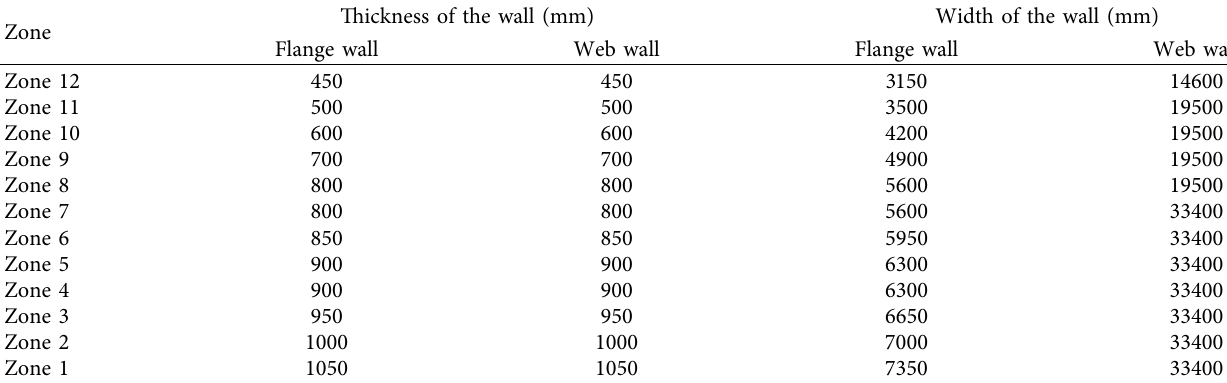
Table 7: Dimension of the prototype